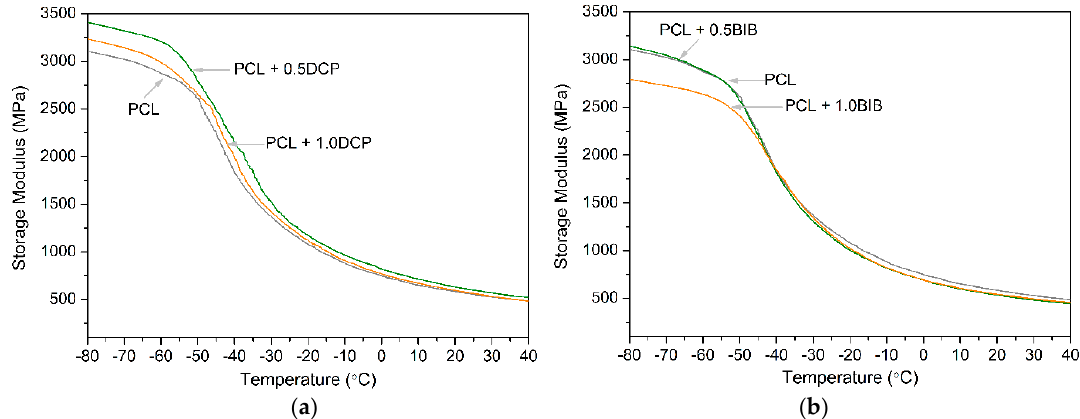
Figure 5. Storage Modulus for PCL modified by DCP ( a ) and PCL modified by BIB ( b )